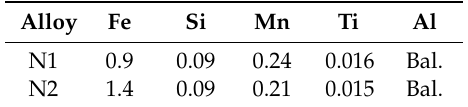
Table 1. Chemical composition of the alloys used in the present study (mass%). Alloy Fe Si Mn Ti Al N1 0.9 0.09 0.24 0.016 N2 1.4 0.09 0.21 0.015